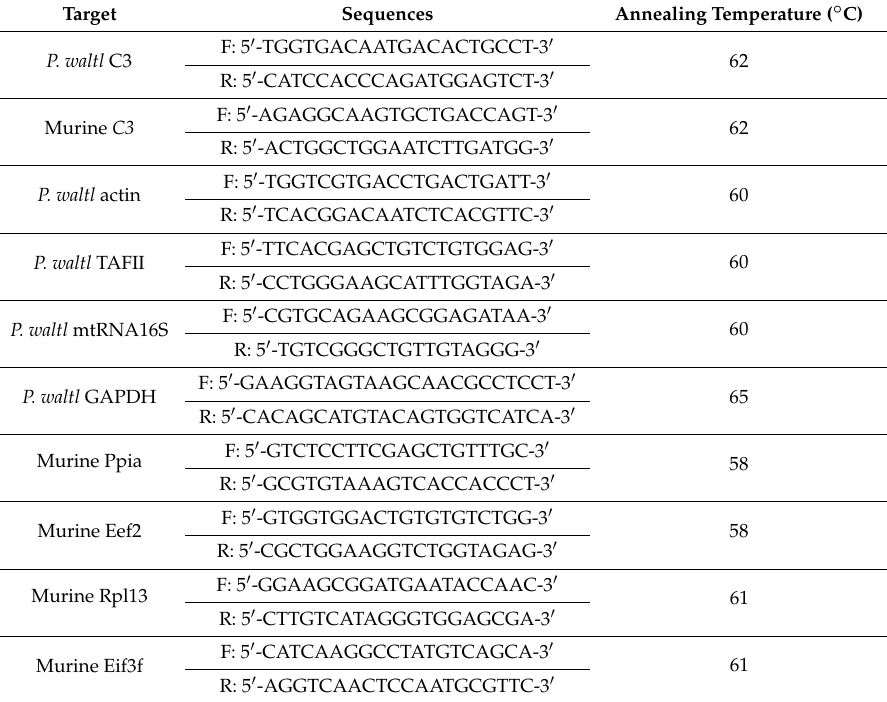
Table 1. Primers used in this study. F, forward. R,